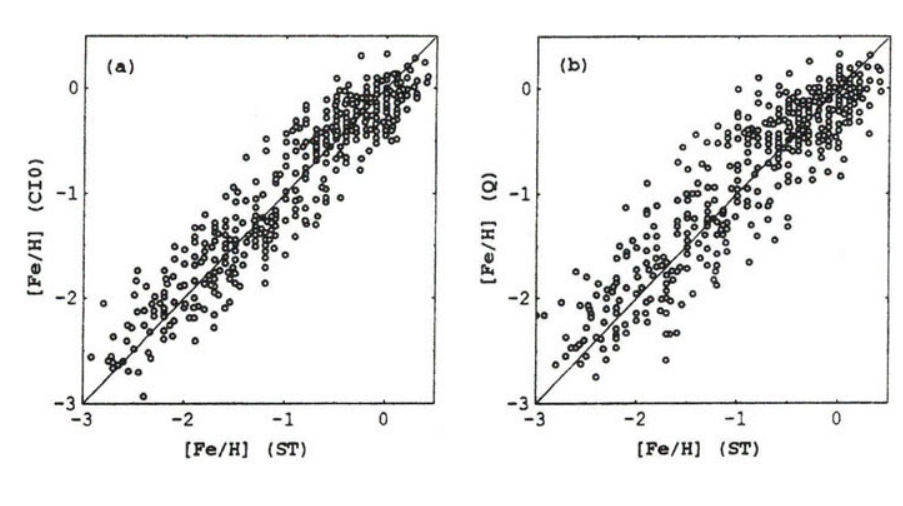
Fig. 3. Comparison of the standard values of [Fe/H] with those derived from a comparison of intrinsic color indices (a) and (^-parameters (b) color indices of the observed stars. These latter values were compared with a set of standard stars and gave the final values of